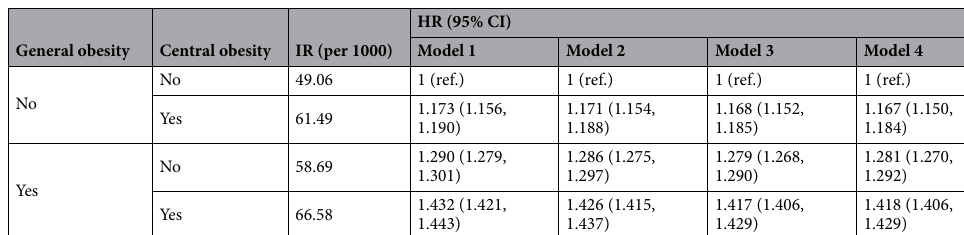
Table 3. Incidence rate and hazard ratio for the risk of knee OA according to general obesity and/or central obesity composition. Model 1 was adjusted for age, sex. Model 2 was adjusted for age, sex, income, smoking, alcohol intake and regular exercises. Model 3 was adjusted for age, sex, income, smoking, alcohol intake, regular exercises, diabetes, hypertension and dyslipidemia. Model 4 was adjusted for age, sex, income, smoking, alcohol intake, regular exercises, diabetes, hypertension, dyslipidemia, cancer, end-stage renal disease, chronic obstructive pulmonary disease, stroke, liver cirrhosis, hear failure, dementia and chronic kidney disease. HR hazard ratio, CI confidence interval, OA osteoarthritis, IR incidence rate.